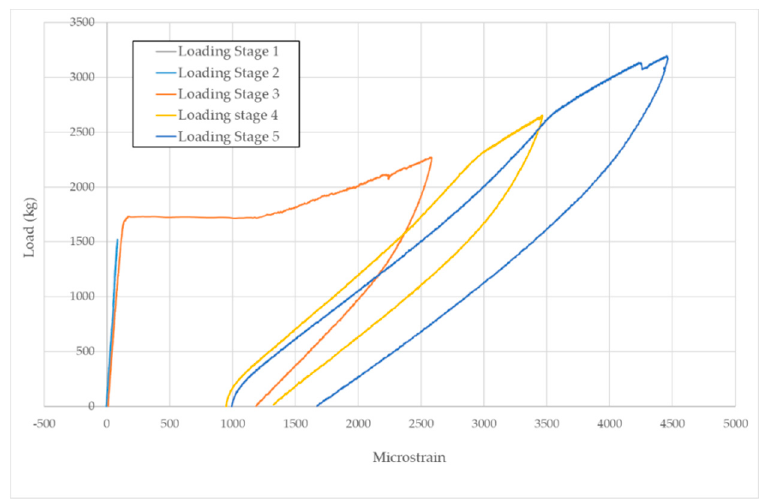
Figure 6. Loading–unloading curves for specimen B.